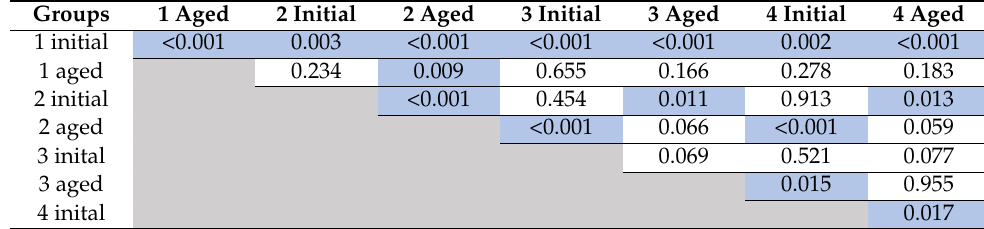
Table A2. Fracture load: p -values (colored: significant